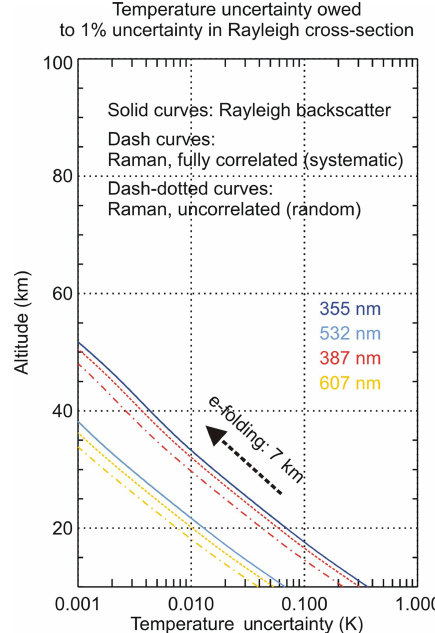
Figure 4. Temperature uncertainty owing to the Rayleigh cross sec- tion used in the molecular extinction correction. The results are shown per 1% in cross section